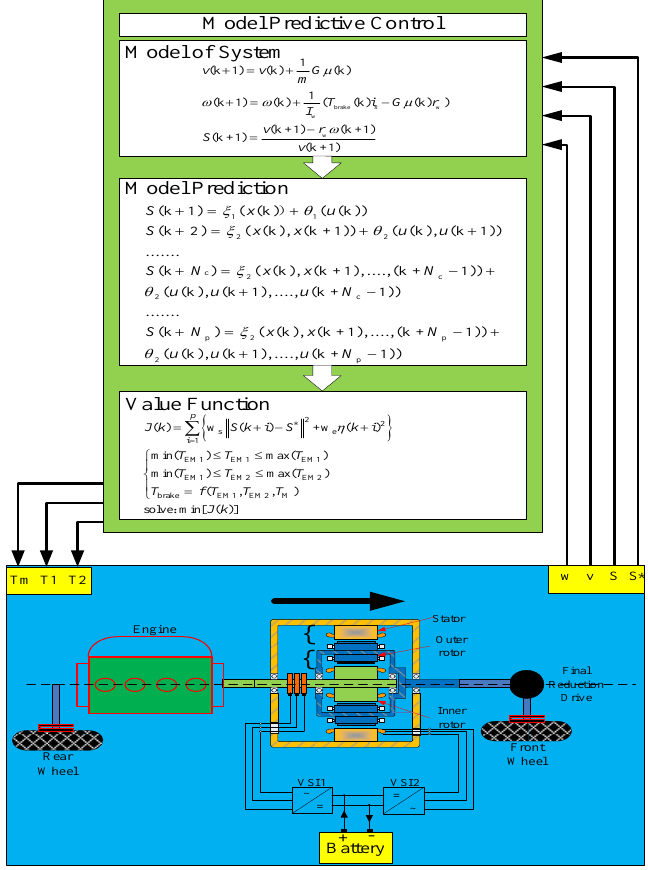
Figure 10. Model prediction algorithm flow.